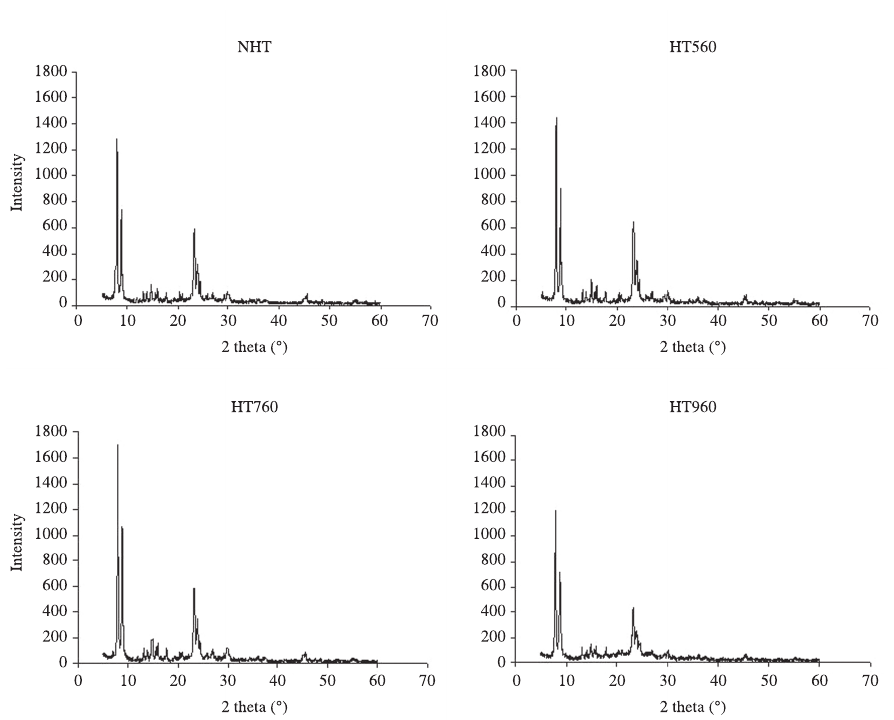
Figure 13. X-ray diffractograms of zeolite samples NHT, HT560, HT760 and HT960.